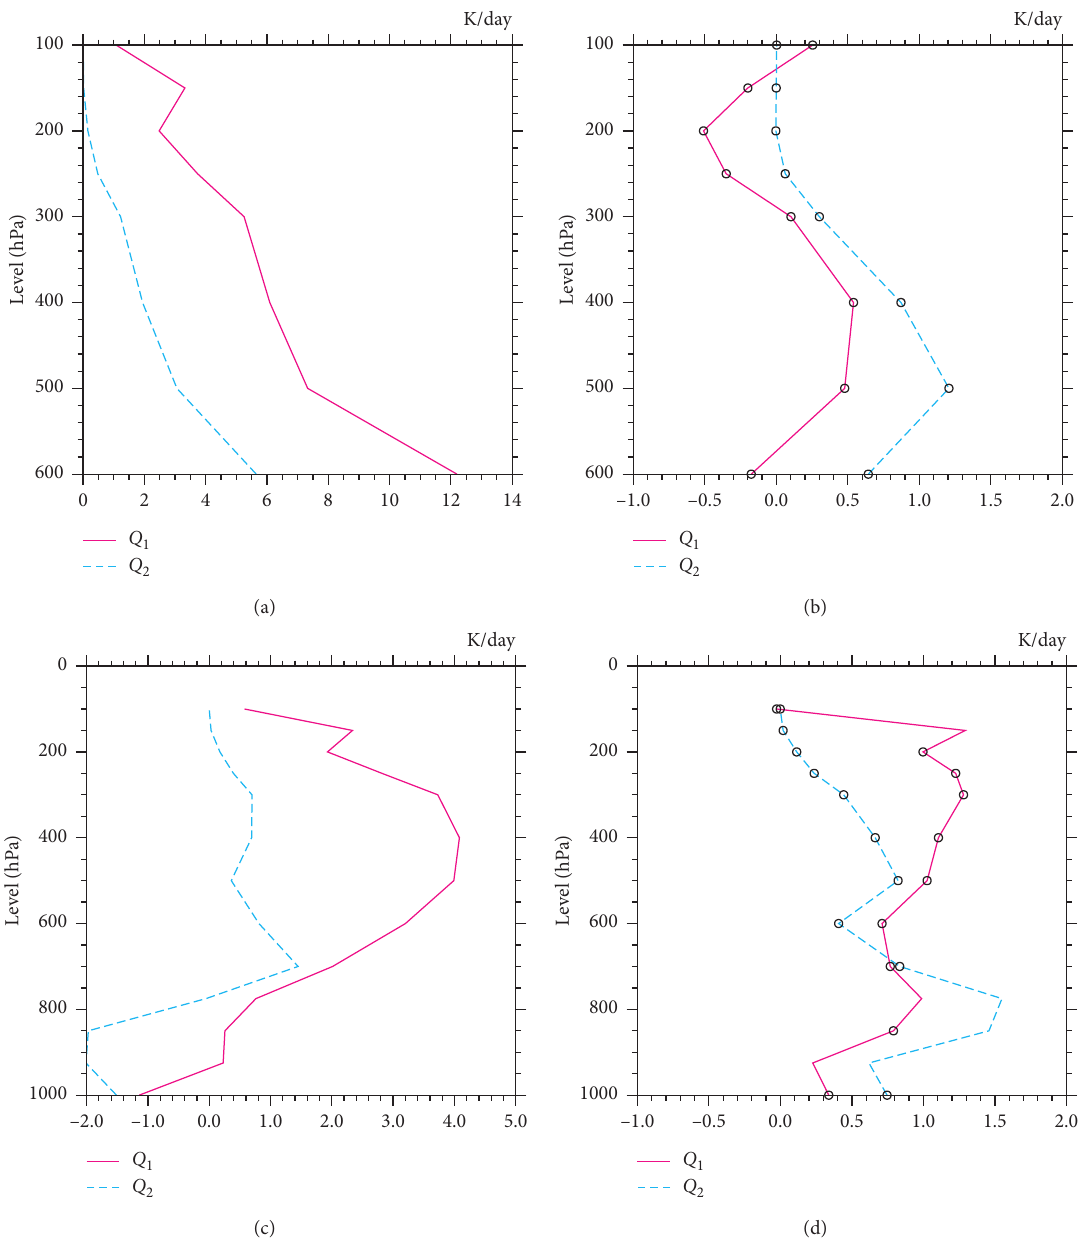
Figure 5: Profile of (a) climatological and (b) composite difference between the strong and weak ISM years of JA apparent heat source ( Q and apparent moisture sink ( Q 2 ) (units: k · day − 1 ) of the atmosphere from 1979 to 2017. Black circles indicate values significantly exceeding the 90% confidence level in (b) and